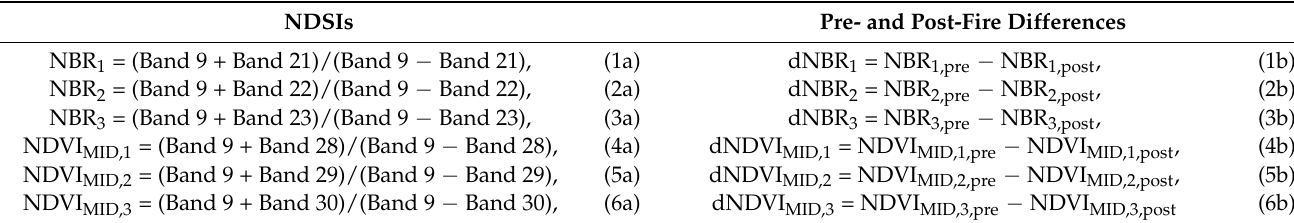
Table 1. Spectral indices used in this study. The MASTER band 9, centred on 0.87 µ m, was used as the NIR band in the spectral index calculations The MASTER bands 21 (centred on 2.16 µ m), 22 (centred on 2.21 µ m) and 23 (centred on 2.26 µ m) cover the SWIR spectral region. The MASTER bands 28 (centred on 3.61 µ m), 29 (centred on 3.76 µ m) and 30 (centred on 3.91 µ m) cover the MIR spectral